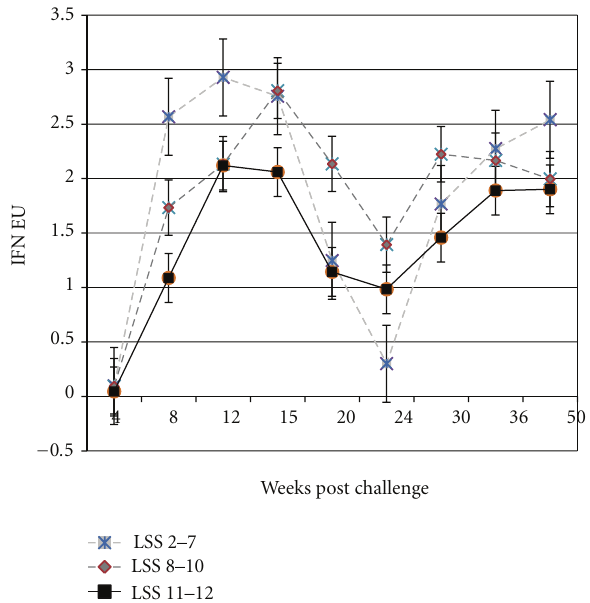
Figure 2: Mean gamma interferon (IFN- γ ) assay results in ELISA units (EUs) for the 14 deer sorted into three groups based on their total lesion severity score (LSS) at week 50 after MAP challenge at day